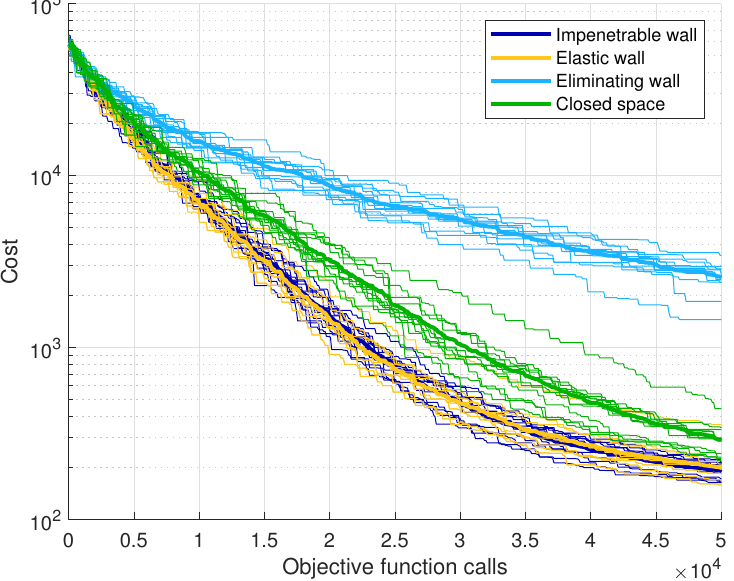
Figure 5. Comparison among the different convergence curves obtained with the four box boundary conditions. The curves are represented in semilogarithmic